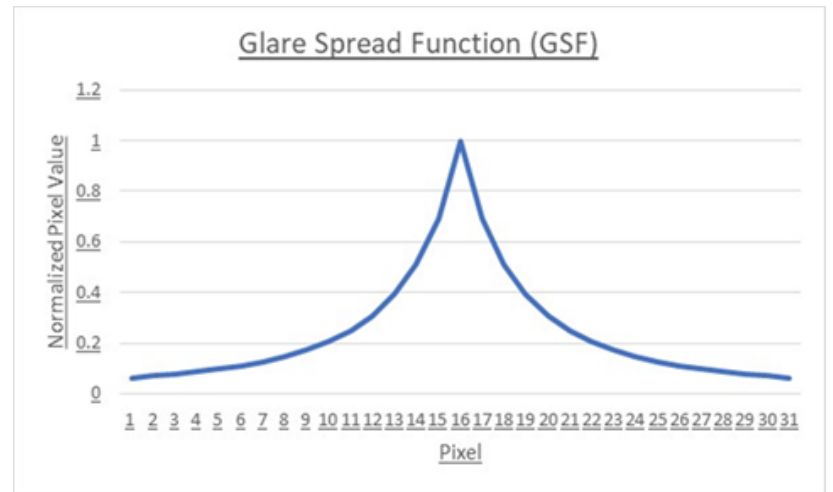
Figure 1. Example of Glare Spread Function (GSF).